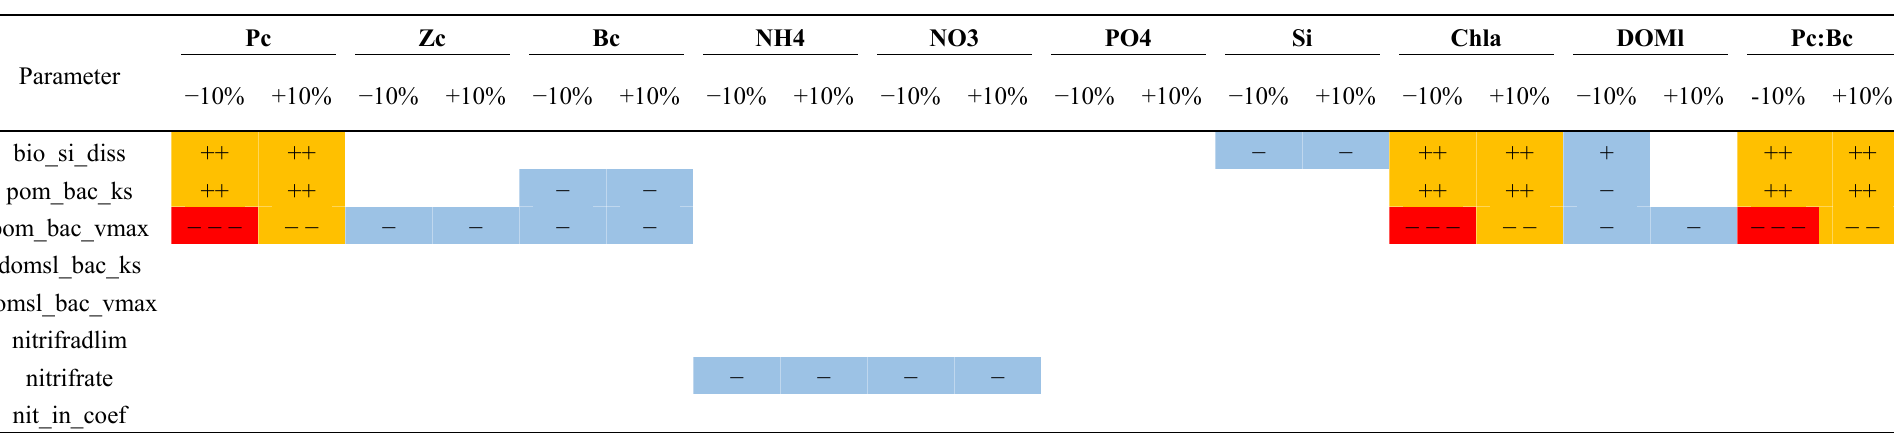
Table 9. SA result matrix for the general parameters impact on the analyzed variables. Color code: blue for sensitive ( S > 0.1), orange for highly sensitive ( S > 1) and red for extremely sensitive (S > 10). The signs + and − stand for positive and negative perturbation, respectively. A description of the variables and parameters is found in Tables 1–5.